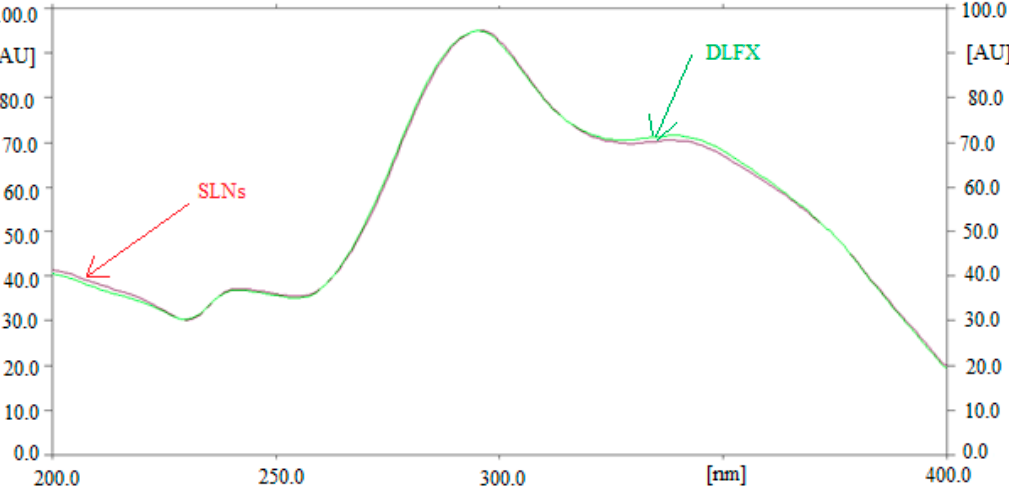
Figure 4. Overlaid UV absorption spectra of standard DLFX and in ‐ house developed SLNs.